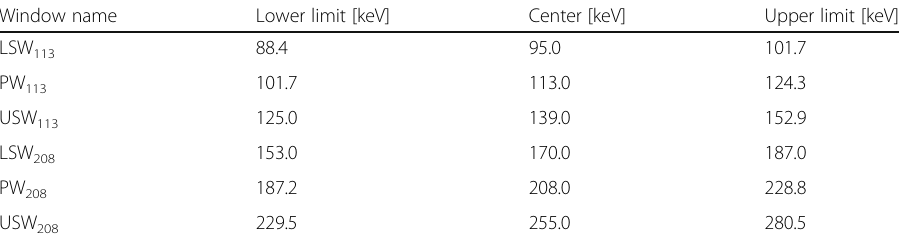
Table 1 Energy window limits for the two photopeaks of 177 Lu. Additional energy windows were used to collect data for the entire